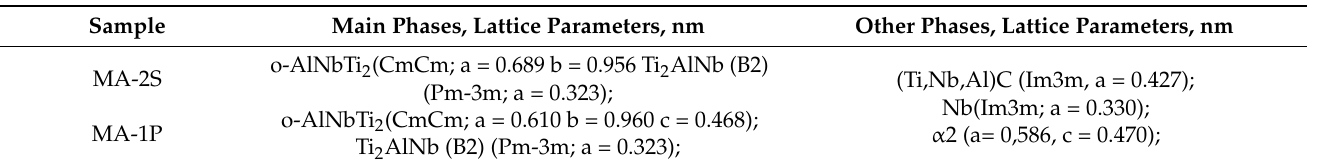
Table 4. Results of X-ray diffraction phase analysis.